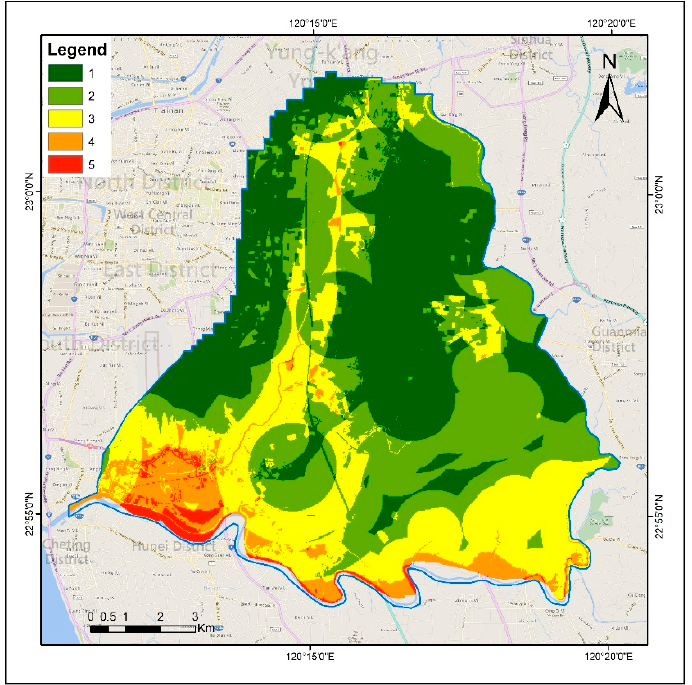
Figure 6. Vulnerability map in five levels from low (green color) to high (red color) .